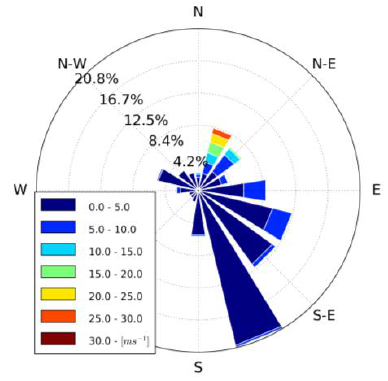
Figure 2. The wind rose from 10-min wind averages of all data. The wind speed category limits are in m · s − 1 , and the numbers on the plot indicate the relative frequency of occurrence.